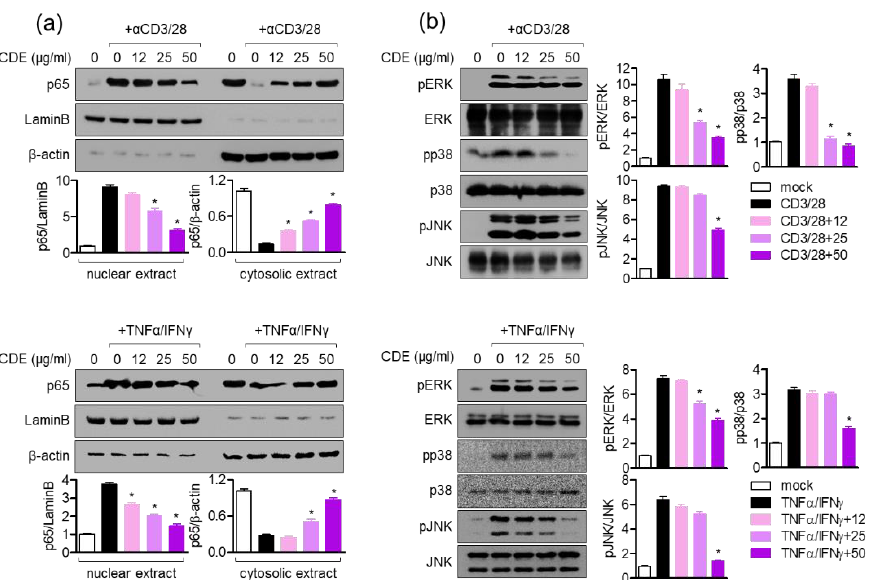
Figure 8. Modulatory effects of CDE on the activity of T cells and keratinocytes involve the NF κ B- MAPK pathway. ( a ) Jurkat cells pretreated with the indicated concentrations of CDE (0–50 µ g/mL) were stimulated with anti-CD3 antibody and anti-CD28 antibody for 10 min, then the cells were harvested and analyzed using Western blot analysis. ( b ) In addition, the indicated concentrations of CDE (0–50 µ g/mL) were stimulated with anti-CD3 and anti-CD28 antibodies for 30 min after 1 h of treatment. Thereafter, the cells were lysed in RIPA buffer that contained 1X phosphatase inhibitor and then subjected to Western blot analysis to detect phosphorylated ERK, phosphorylated p38, and phosphorylated JNK. Phosphorylated levels were normalized to the intensity of total protein and displayed as bar graphs. Results are presented as the mean ± SEM of three independent experiments (* p <